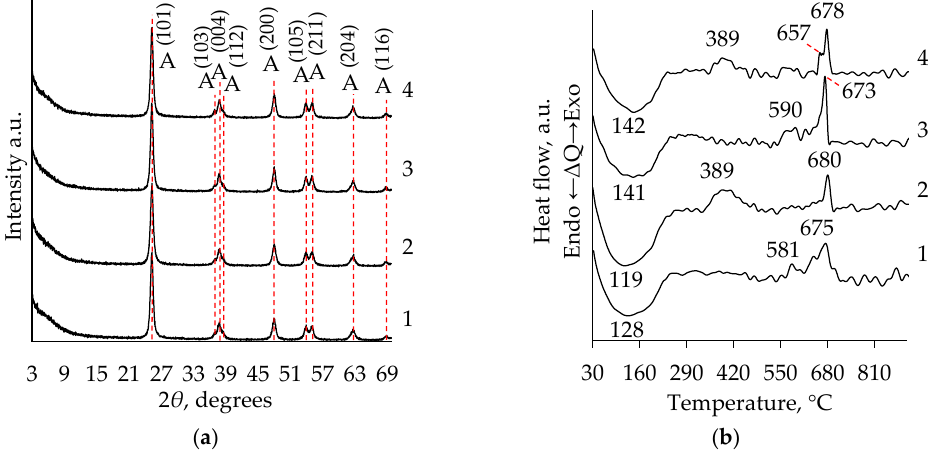
Figure 2. Effect of calcination on XRD ( a ) and DTA ( b ) patterns of TiO 2 aerogel (( 1, 3 ) without ageing; ( 2, 4 ) after ageing. 1 , 2 curves correspond to precursor TIP and 3 , 4 —to TBOT. Indexes: A—anatase